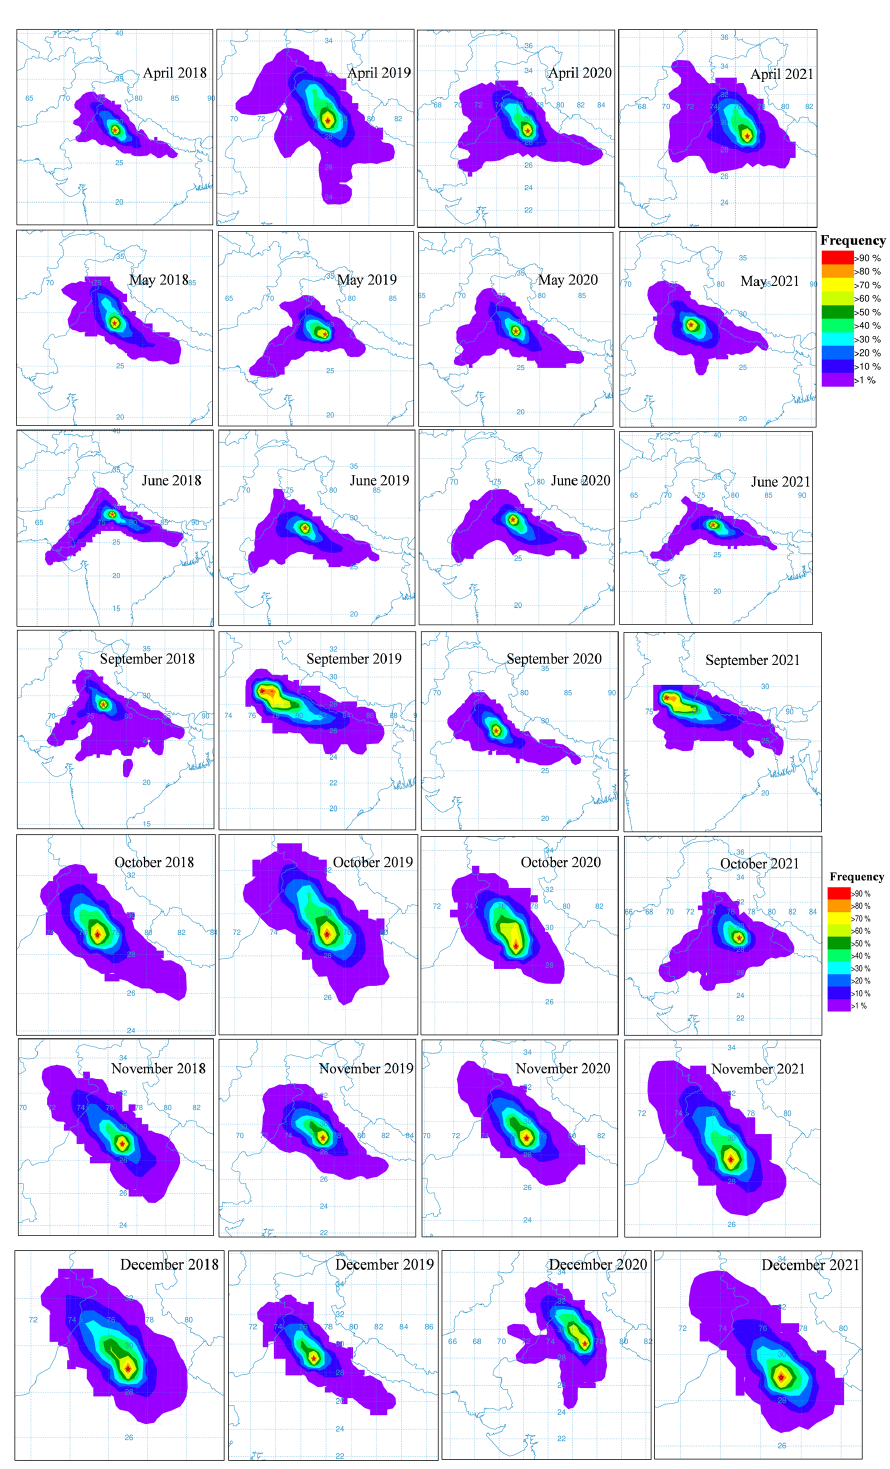
Figure 14. Frequency of backward trajectories during April-June for 2018, 2019, 2020, and 2021. Frequency of backward trajectories from September to December for 2018, 2019, 2020, and 2021.